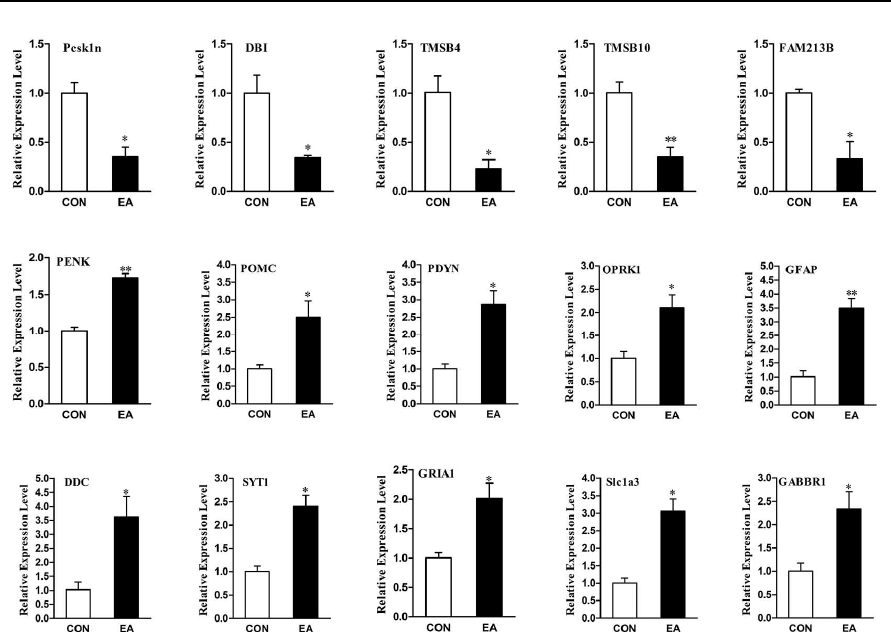
Figure 5. qRT-PCR validation of DEGs. The reliability of the sequencing data was validated by qRT-PCR. The change tendency of fifteen DEGs was consistent with the results from sequencing data. The data depicted by the y -axis were calculated using the expression values of 2 − ∆∆ C t and expressed as the mean ± SD in triplicate. The significance of differences in expression between samples was calculated by a t test. * Compared with the control p < 0.05. ** Compared with the control p < 0.01.